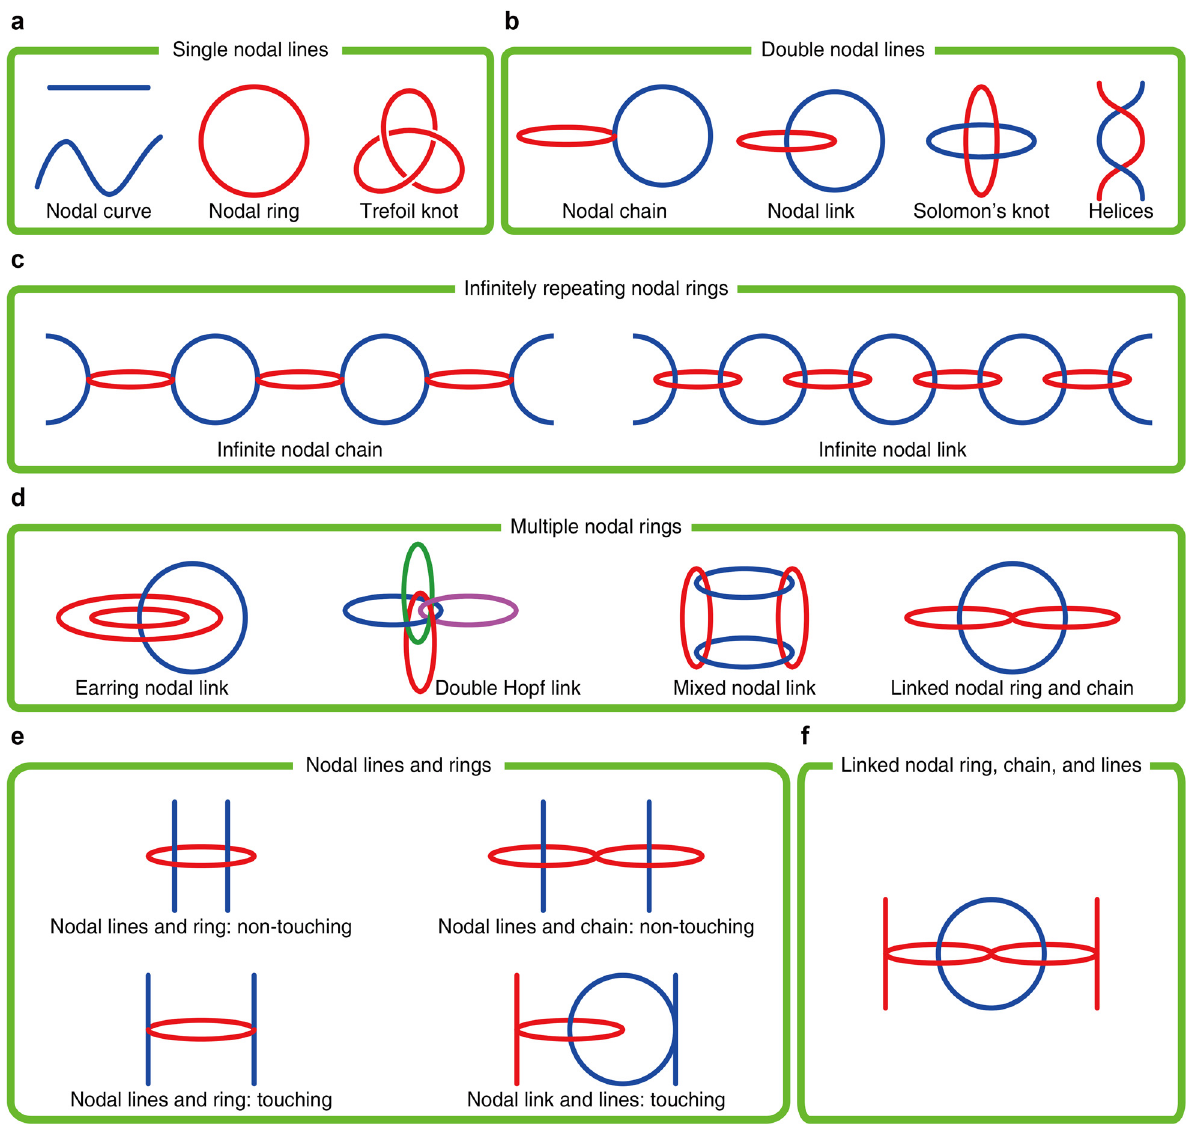
Figure 2: Classification of nodal